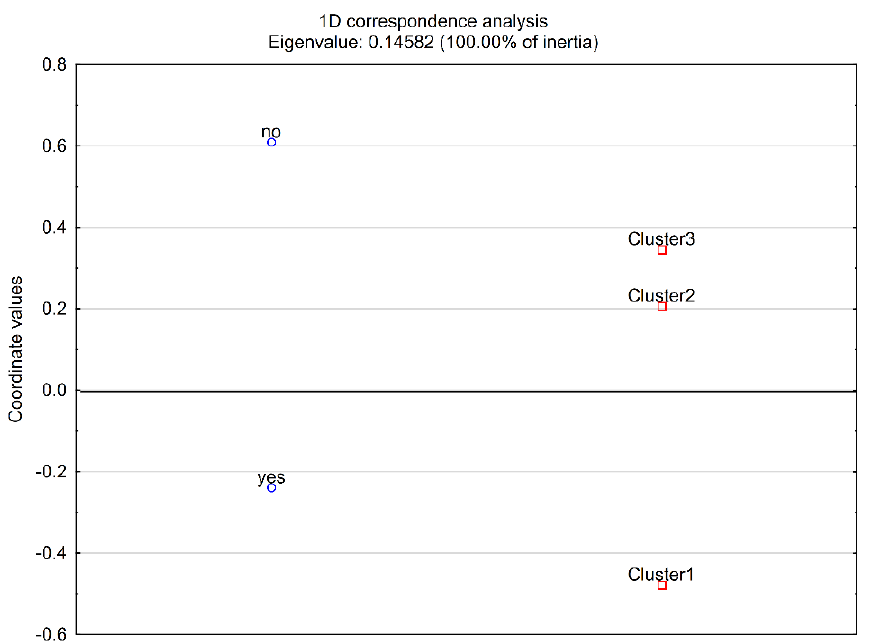
Figure 3. Correspondence analysis plot−relationship between clusters and remission state.